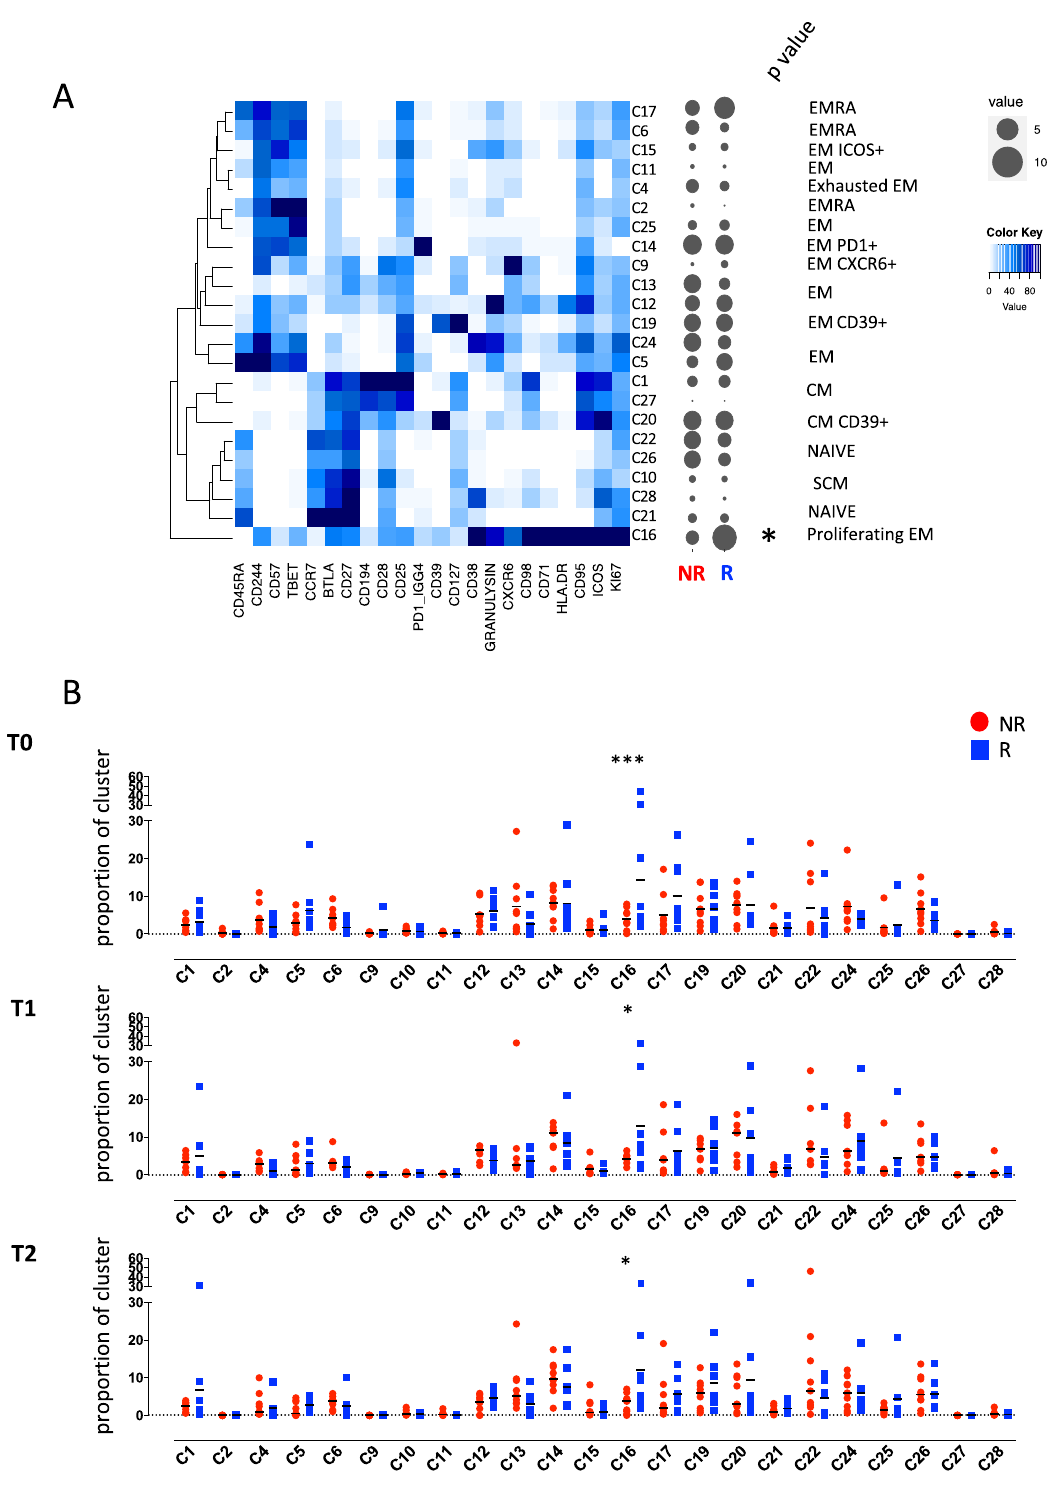
Fig. 1 High-dimensional single-cell analysis of CD8 + T cells identi fi es higher proportion of activated effector memory T cells in responders. A Heatmap showing the iMFI of speci fi c markers in discrete Phenograph clusters. Ballons indicate the median frequency of each cluster amongst responders and non- responders. Statistical analysis by two-sided Mann – Whitney nonparametric test, Bonferroni ’ s multiple comparisons test, * p = 0.046. B Proportion of cell within each cluster for each individual. Data represent individual values, mean (center bar) ± SEM (upper and lower bars). Statistical analysis by two-sided Mann – Whitney nonparametric test, Bonferroni ’ s multiple comparisons test; T0, *** p < 0.0001; T1, * p = 0.046; T2 p = 0.037. T0 = before therapy, T1 = after 1 cycle of therapy, T2 = after two cycles of therapy. Individual measurements of NR = 9, R = 8. Source data are provided as a Source Data fi le.